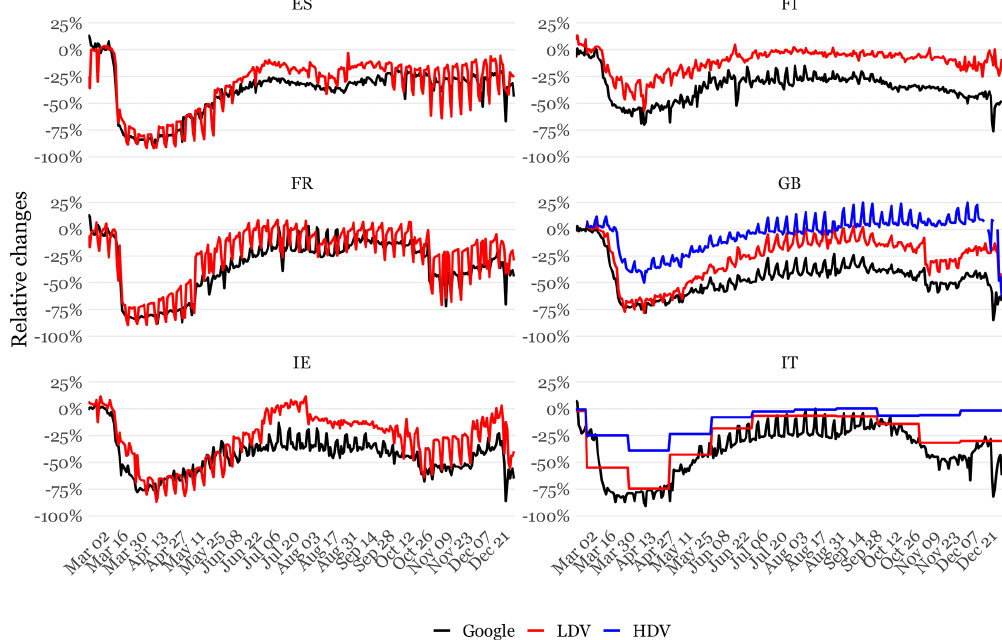
Figure 4. Comparison of traffic movement trends derived from Google COVID-19 Community Mobility Reports (Google LLC, 2021) and measured traffic counts for selected countries (see Table A1 for references), the latter kind being distinguished by type of vehicle (i.e. heavy- duty vehicles, HDVs; light-duty vehicles and cars, LDVs), for the period 21 February to 31 December